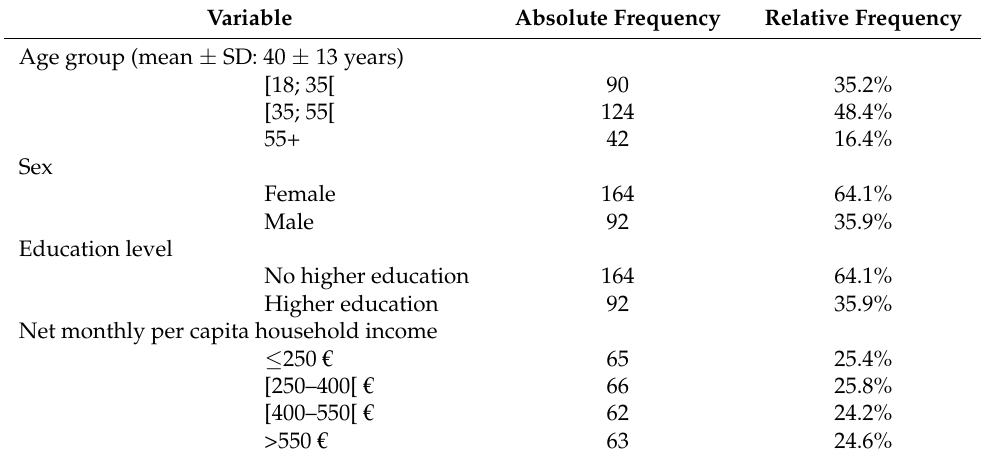
Table 1. Sociodemographic characteristics of the participants (n =